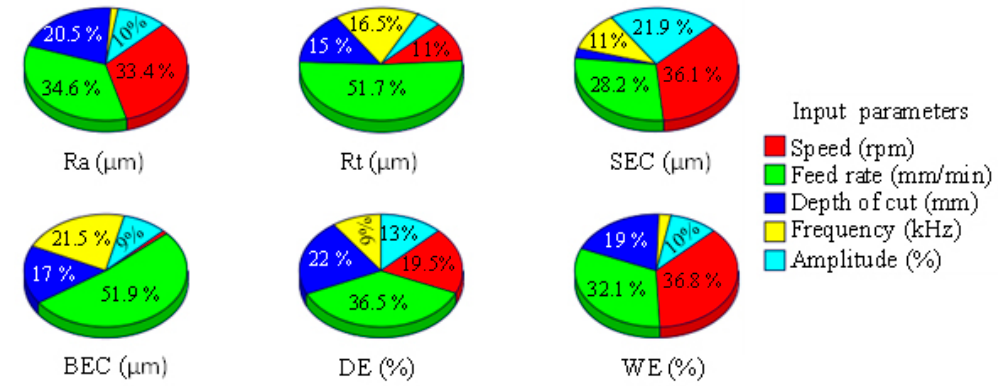
Figure 8. Percentage of the effect of RUM input parameters on the outputs. Legend: Ra, arithmetic mean roughness; Rt, maximum height of the roughness profile; SEC, side edge chipping; BEC, bed edge chipping; DE, depth error; WE, width error.